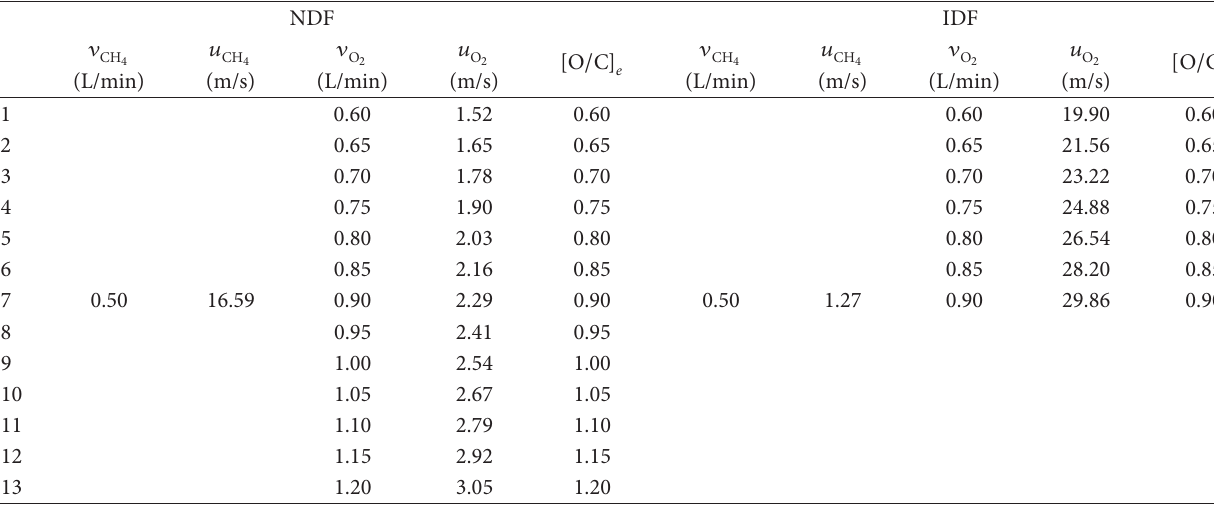
T 1: Flame conditions a used in different experiment numbers.